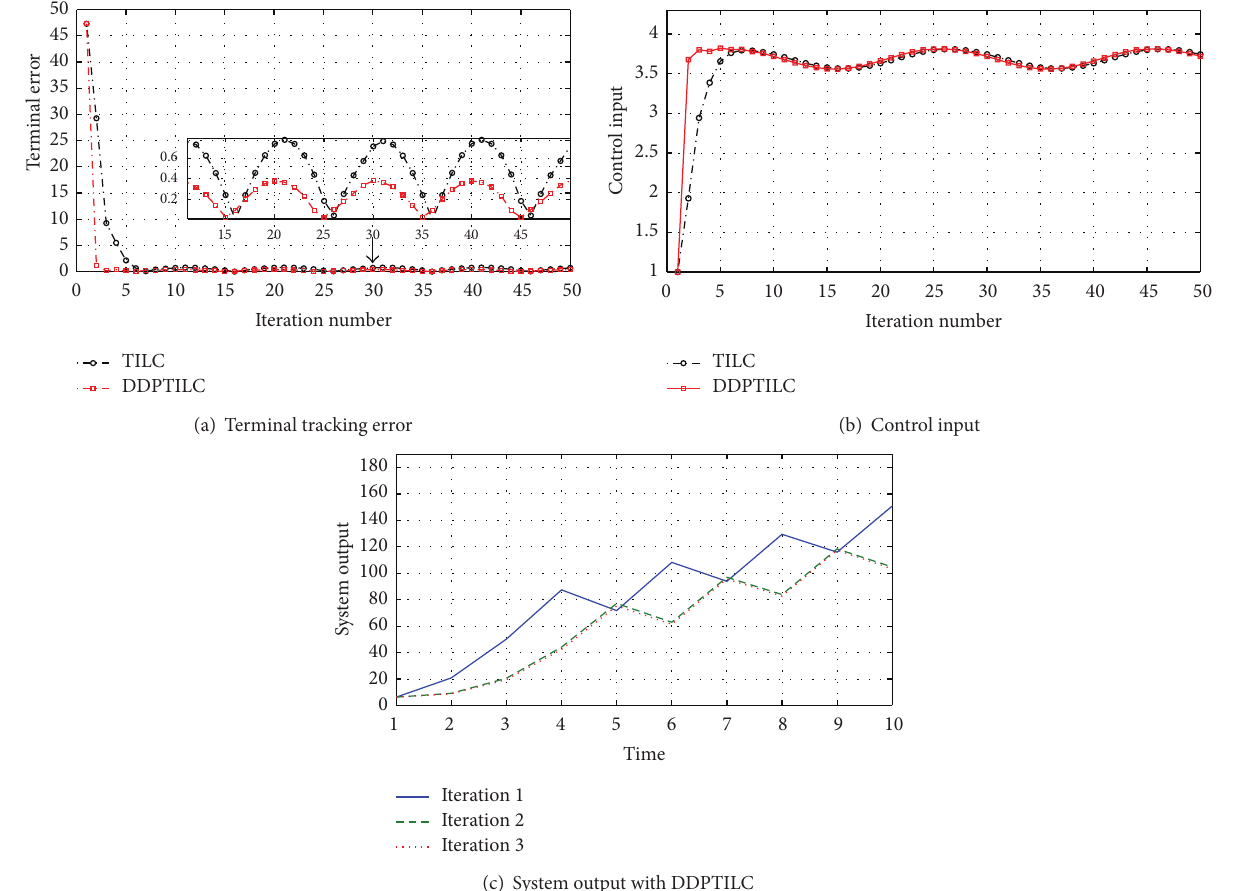
Figure 3: Simulation comparison between TILC and DDPTILC (Case